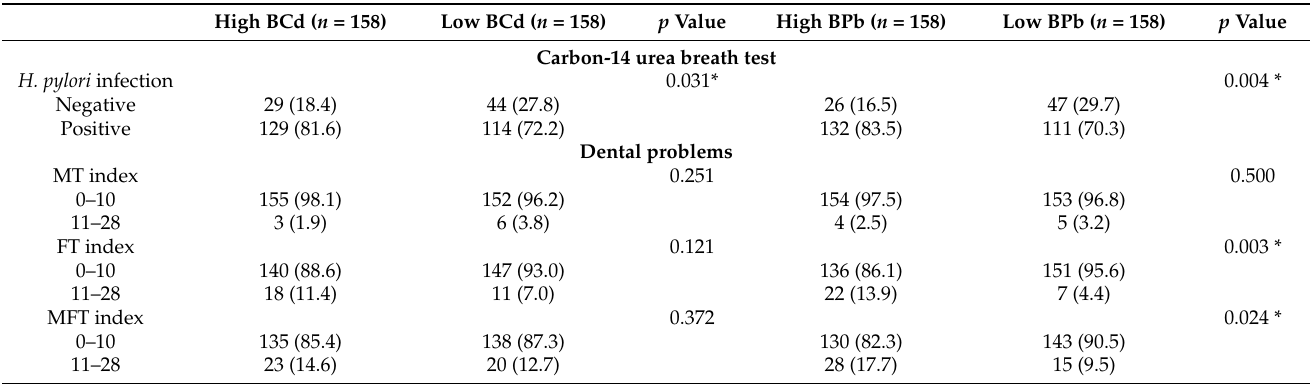
Table 2. Association of H. pylori infection and dental problems with heavy metal exposure